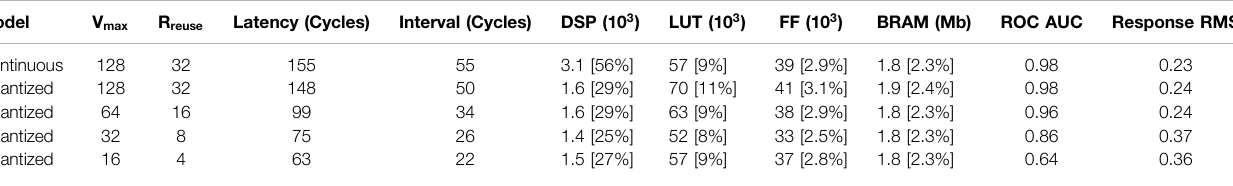
TABLE 1 | Summary of the latency, II, FPGA resource usage metrics, and inference accuracy metrics of the synthesized fi rmware. The reported resource usage numbers re fl ect the synthesis estimates from Vivado HLS. The target FPGA is a Xilinx Kintex UltraScale FPGA (part number xcku115- fl vb2104-2-i), which has 5,520 DSPs, 663,360 LUTs, 1,326,720 FFs, and 77.8 Mb of BRAM (Xilinx, 2020). The utilized percentage of the targeted FPGA resources are denoted in the square brackets.